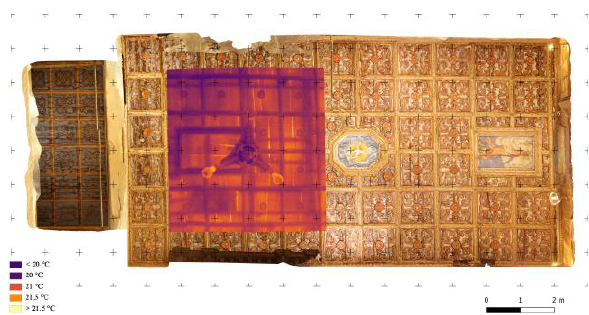
Figure 7. Coffered ceiling of the Santuario della Madonna delle Grazie in Varoni (RI): overlay of the thermal and true colour orthoimagery.